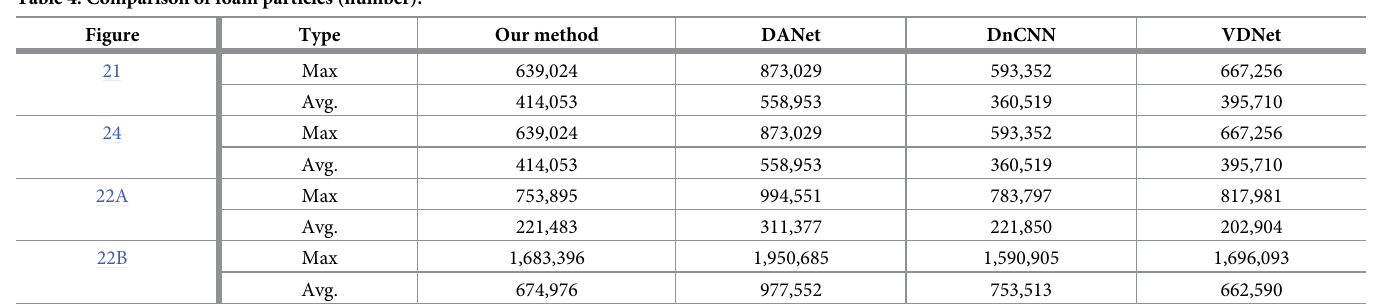
Table 4. Comparison of foam particles (number).